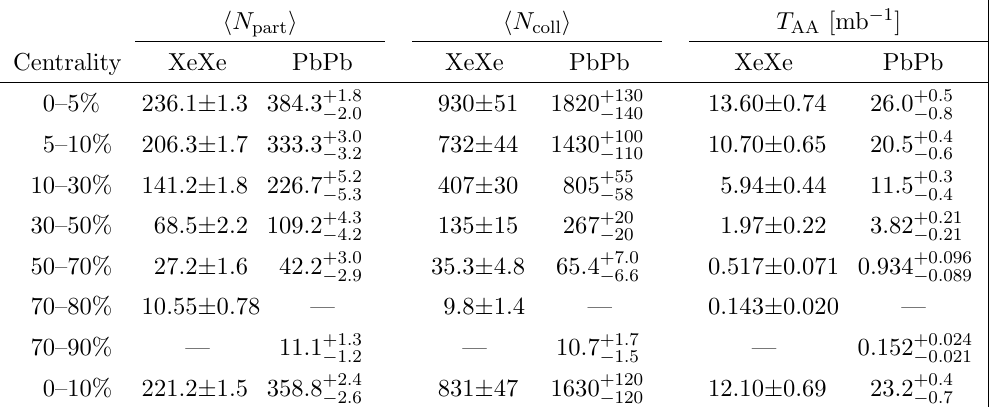
p s = 5 : 44 TeV XeXe NN